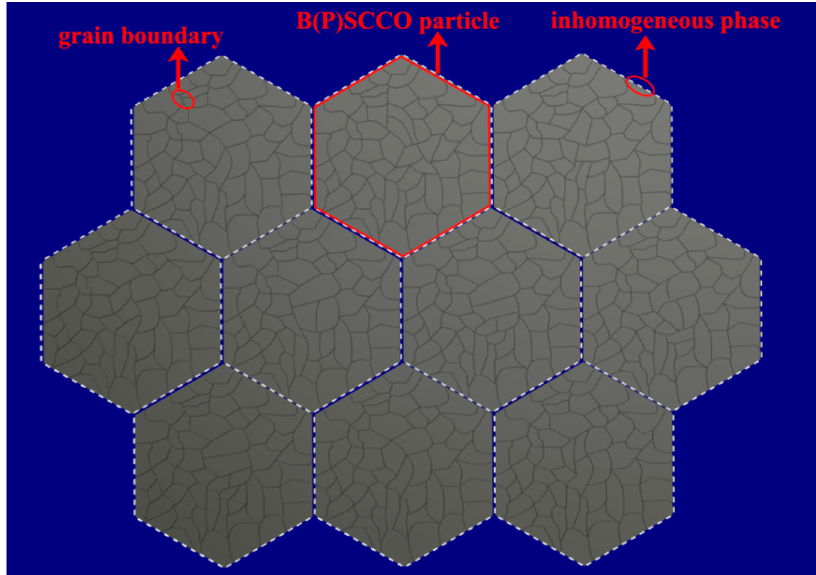
Figure 1. The model of the smart meta-superconductor B(P)SCCO.